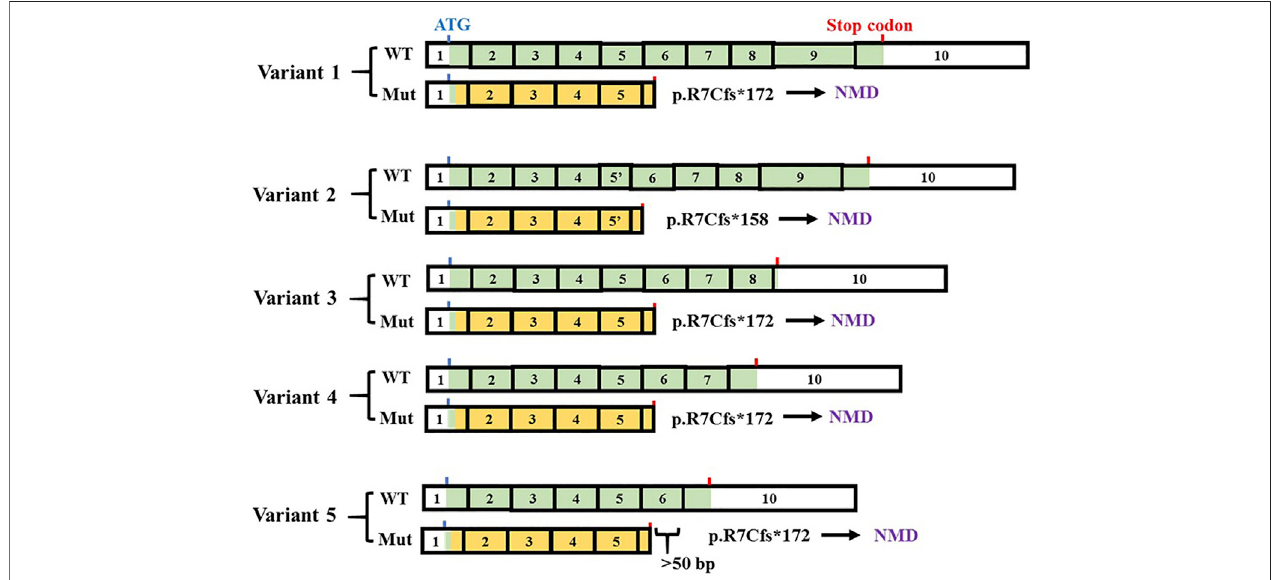
FIGURE 3 | TNFRSF11A isoforms and the effect of the variant (c.19_31del). Five variant transcripts are in NCBI database (variant 1: NM_003839.3; variant 2: NM_001278268.1, variant 3: NM_001270949.1, variant 4: NM_001270950.1, variant 5: NM_001270951.1). The exons are numbered based on the longest variant (variant 1). The changed parts of coding sequence are labeled in orange. The positions of the fi rst ATG and the stop codons were indicated by blue and red bars, respectively. c.19_31del produces no transcripts due to nonsense mutation-mediated mRNA decay (NMD).